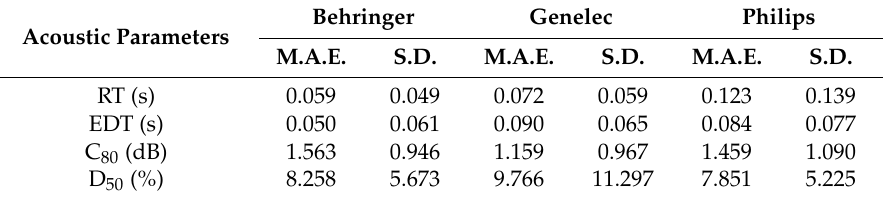
Table 4. Mean Absolute Error (M.A.E.) and Standard Deviation (S.D.) of RT, E.D.T., C 80 and D 50 for measurements with different speakers compared with measurements with the dodecahedron